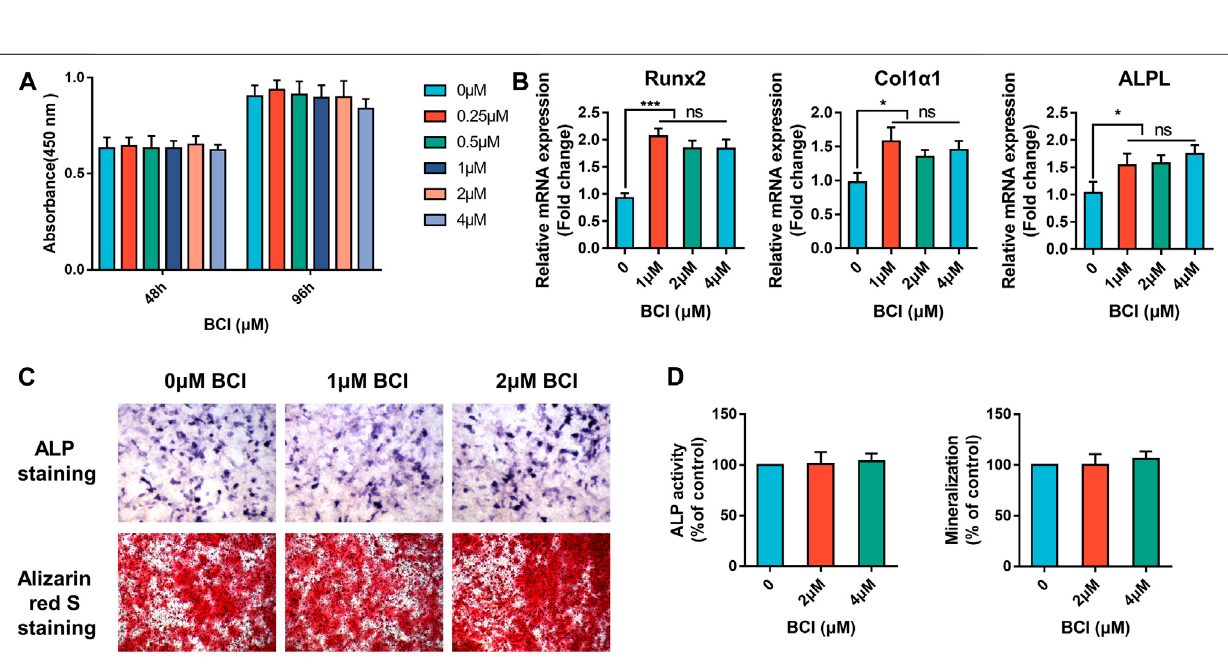
Frontiers in Pharmacology |